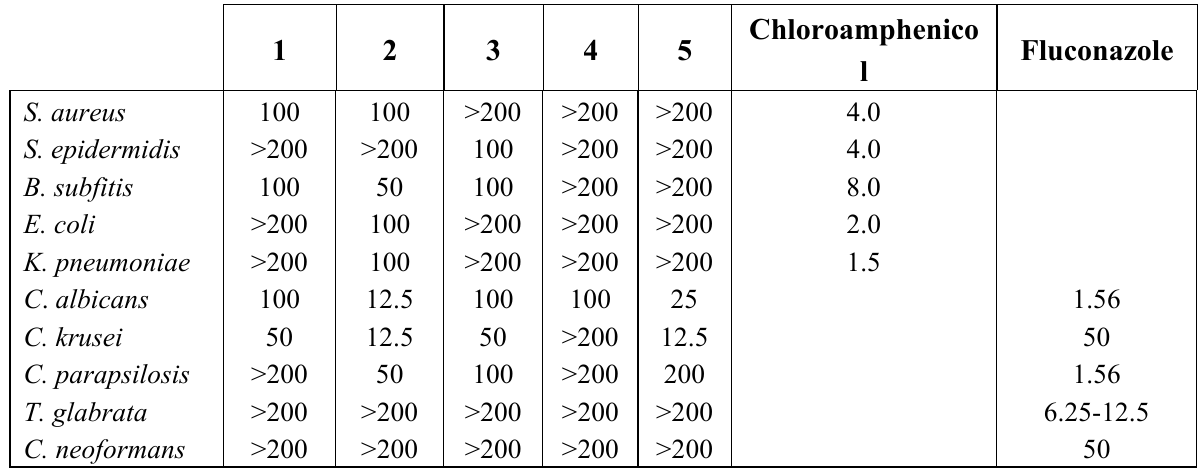
Table 2. MIC a Values of 1 - 5 for Antimicrobial Activities ( μ g/mL).